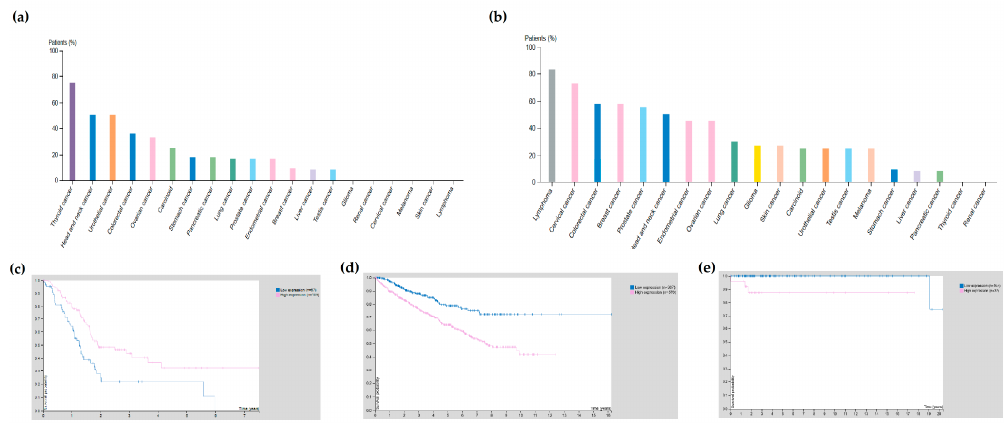
Figure 2. The expression of CNR1 , CNR2 , GPR119 and TRPV2 in cancer according to the Human Protein Atlas database [13]. ( a ) Expression of CNR1 in cancer subtypes; ( b ) expression of CNR2 in cancer subtypes; ( c ) survival curves of pancreatic cancer patients according to the expression of